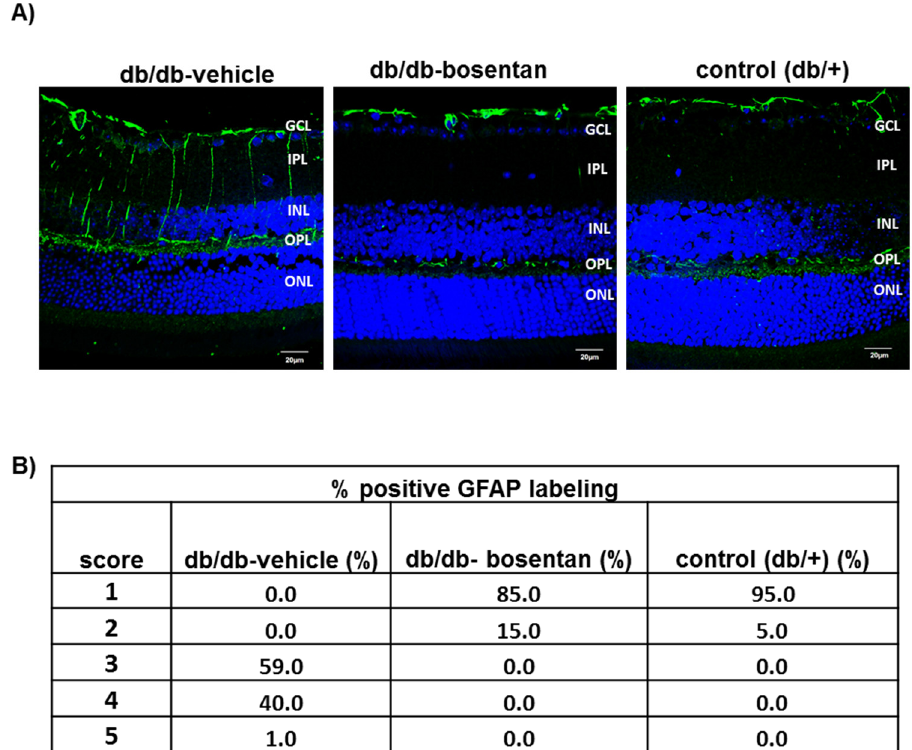
Figure 3. Glial activation. ( A ) Comparison of glial fibrillary acidic protein (GFAP) immunofluorescence (green) between representative samples from a db/db mouse treated with vehicle, a db/db mouse treated with bosentan and a non-diabetic mouse. In the diabetic mouse treated with vehicle, the Müller cells’ endfeet show abundant GFAP immunofluorescence and the radial processes stain intensely throughout both the inner and outer retina. Nuclei were labeled with DAPI (blue). GCL: Ganglion cell layer; IPL: Inner plexiform layer; INL: Inner cell layer; OPL: Outer plexiform layer; ONL: Outer nuclear layer; ( B ) Quantification of glial activation based on extent of GFAP staining. n = 6 mice per group (10 sections per retina).